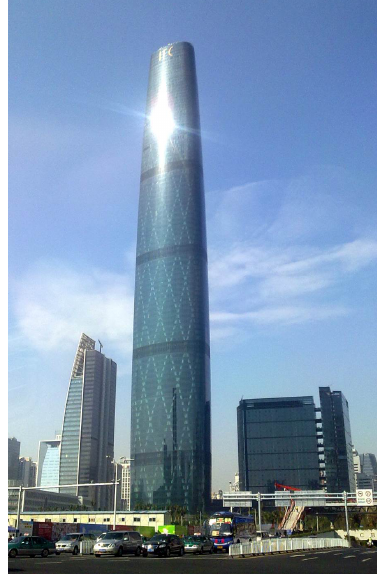
Figure 8. Guangzhou International Finance Center (source: